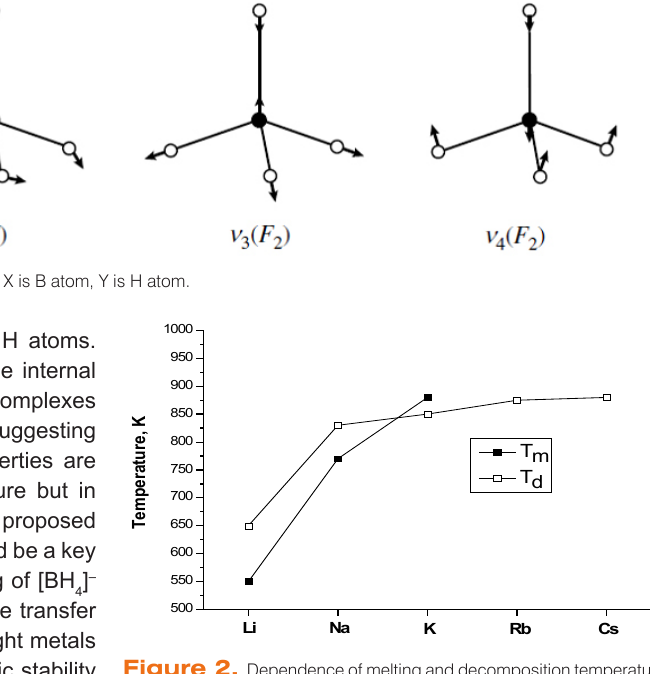
(T and T , respectively) for MBH m d